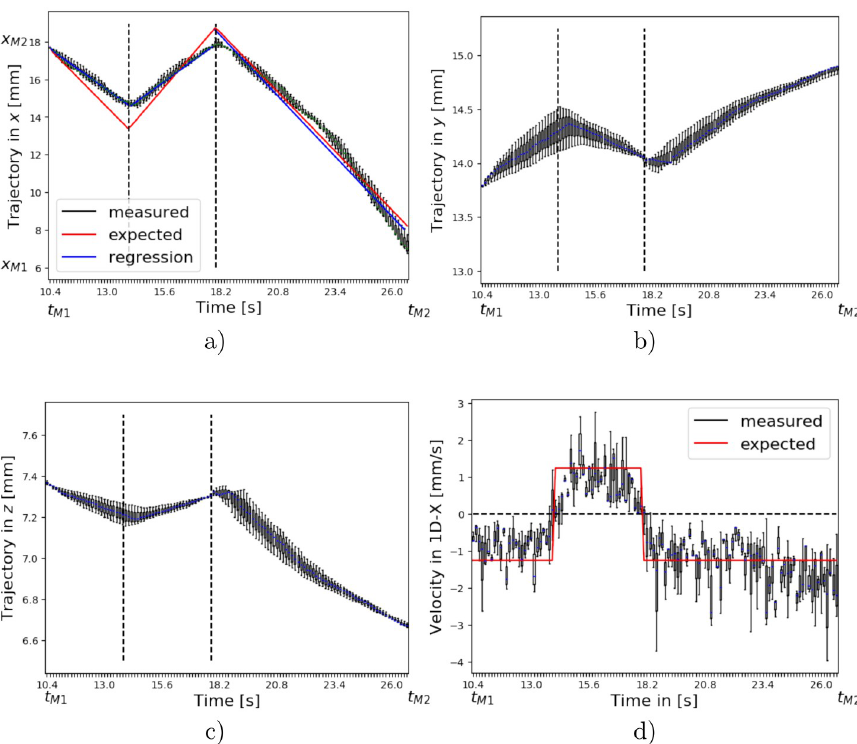
Fig 7. a) The measured distances in x agree with the set catheter movement. The turning points are clearly visible. The velocity, however, is underestimated in the first two segments. In the third segment the measured distances in x agree with the expected positions in x . b) The measure distance in y and c) z shows that the stenosis phantom is inserted slightly diagonal and the back and forth movement is also noticeable in the y and z dimension. d) The inversion of the velocity is visible and the mean velocity value are within the range of the expected velocities. However, the spread of the velocity is quite high.